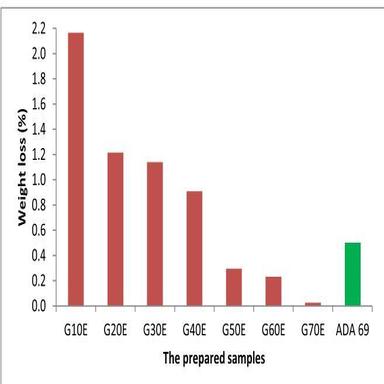
Loss wt% of the investigated glasses after heat- treatment at550◦C, 2h then at 800◦C, 2h.